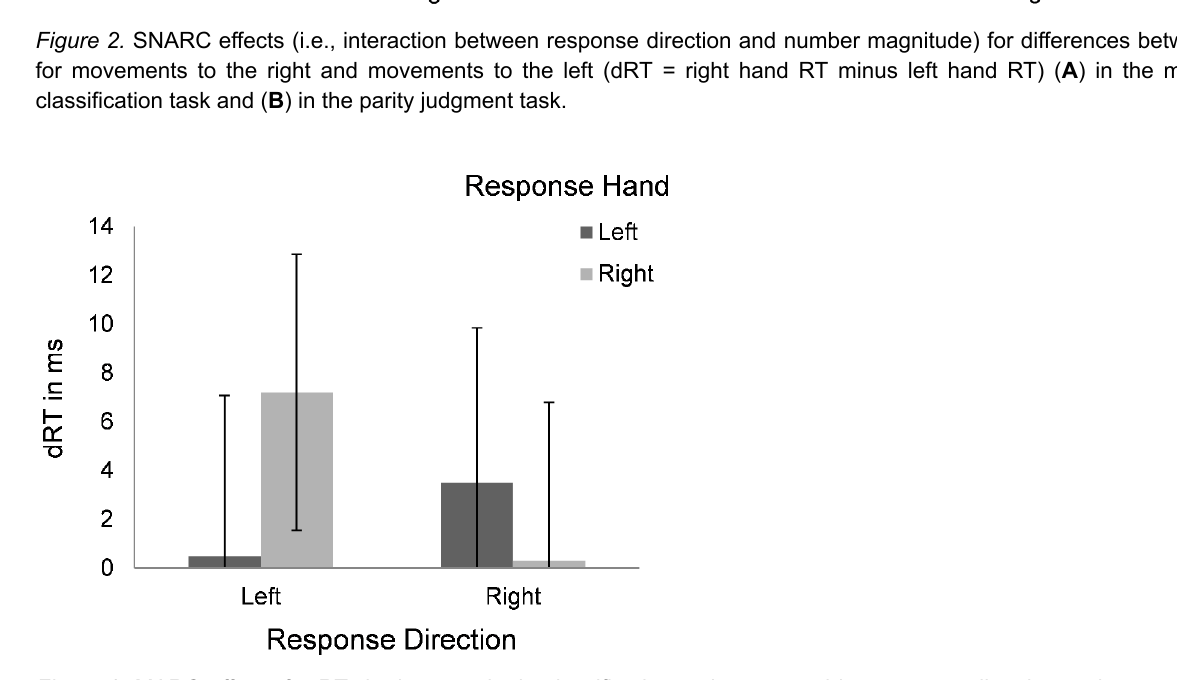
Figure 3. MARC effects for RTs in the magnitude classification task separated by response direction and response hand. The MARC effects are depicted as differences between odd and even numbers (dRT = RT odd numbers minus RT even numbers). Positive values indicate a regular MARC effect (faster responses to even compared to odd